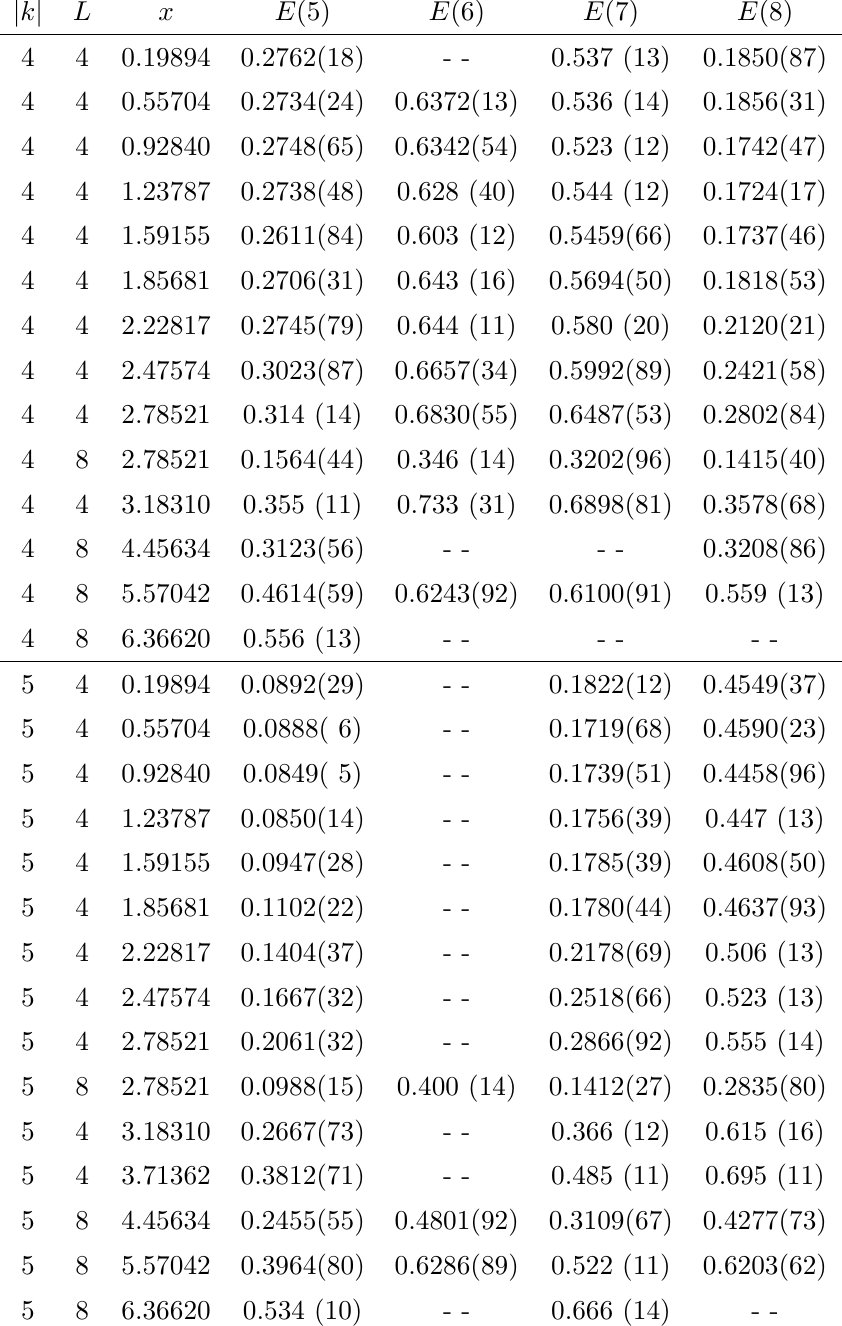
Table 14. SU(17) torelon energies (in lattice units)